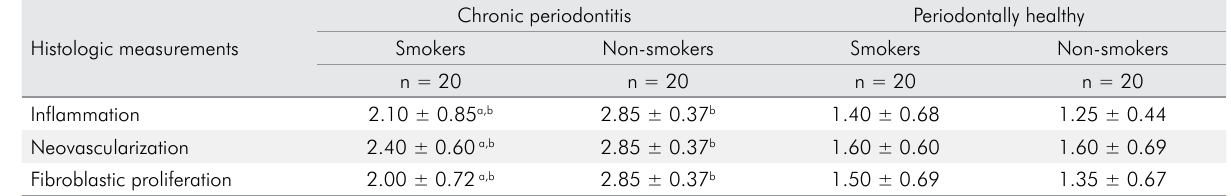
Table 2. Histologic measurements (mean ± standart deviations) of smoker and non-smoker chronic periodontitis and periodontally healthy subjects.